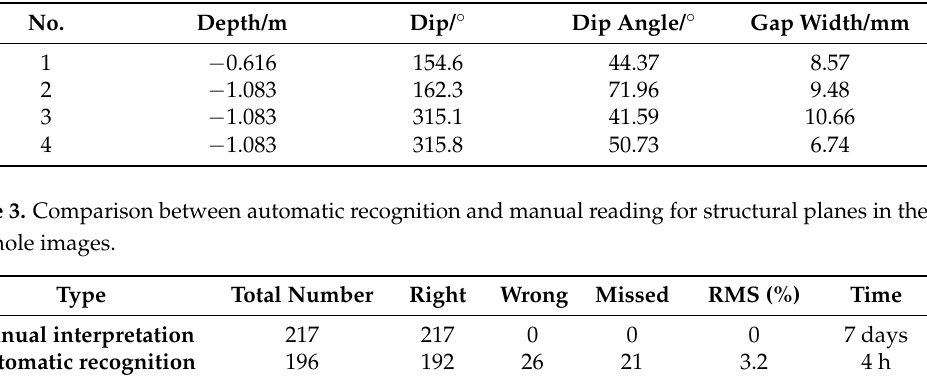
Table 3. Comparison between automatic recognition and manual reading for structural planes in the borehole images.